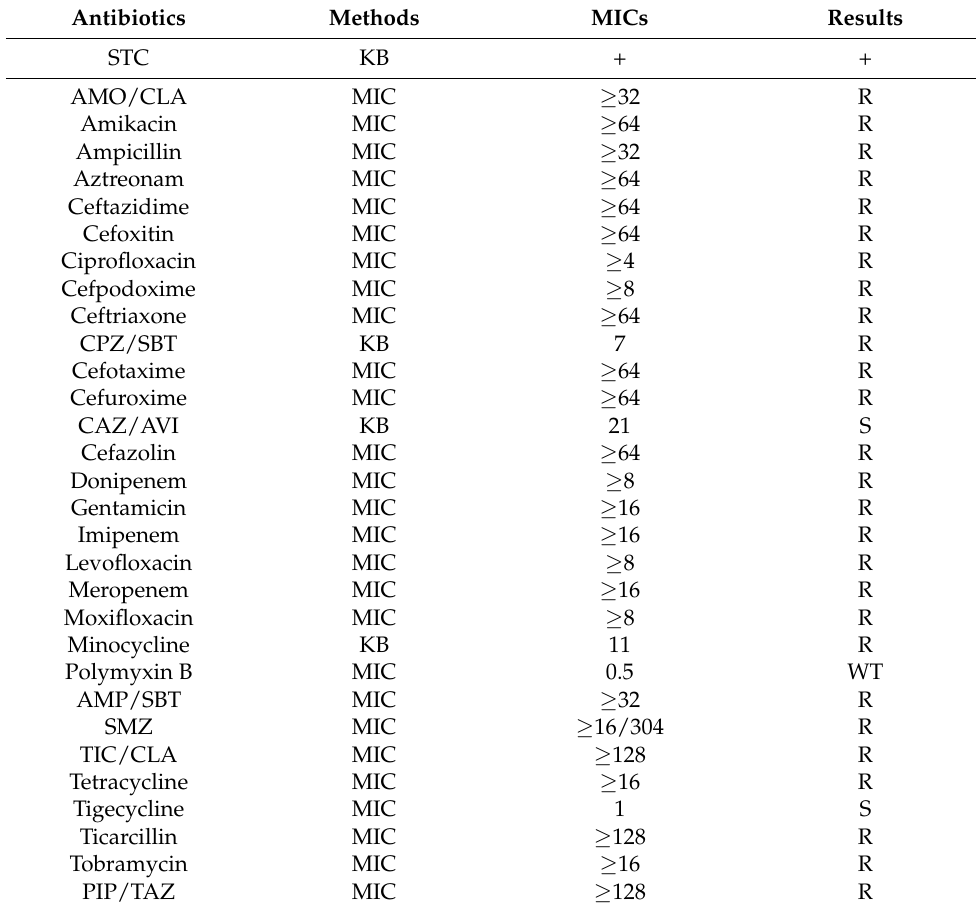
Table 1. The susceptibility results of antimicrobials against Klebsiella pneumoniae *. Antibiotics